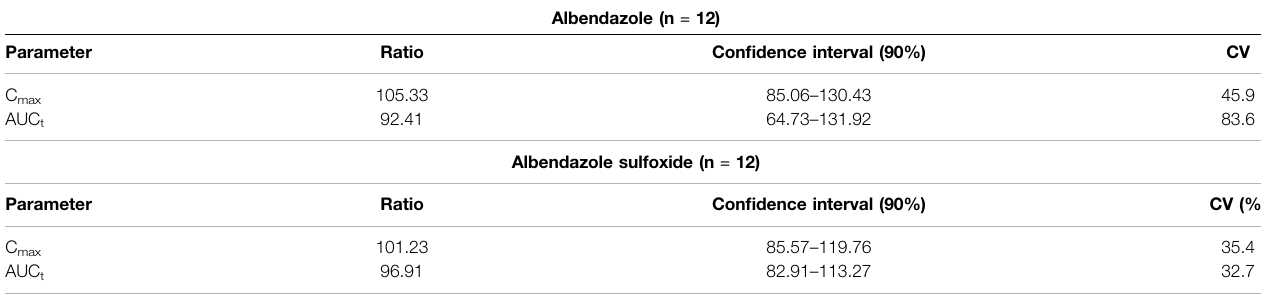
TABLE 5 | Analysis of bioequivalence considering an ANOVA model that includes sequence, subject (sequence), type of breakfast, period, and formulation. Ratio (test/ reference) and 90% con fi dence interval. Albendazole (n =